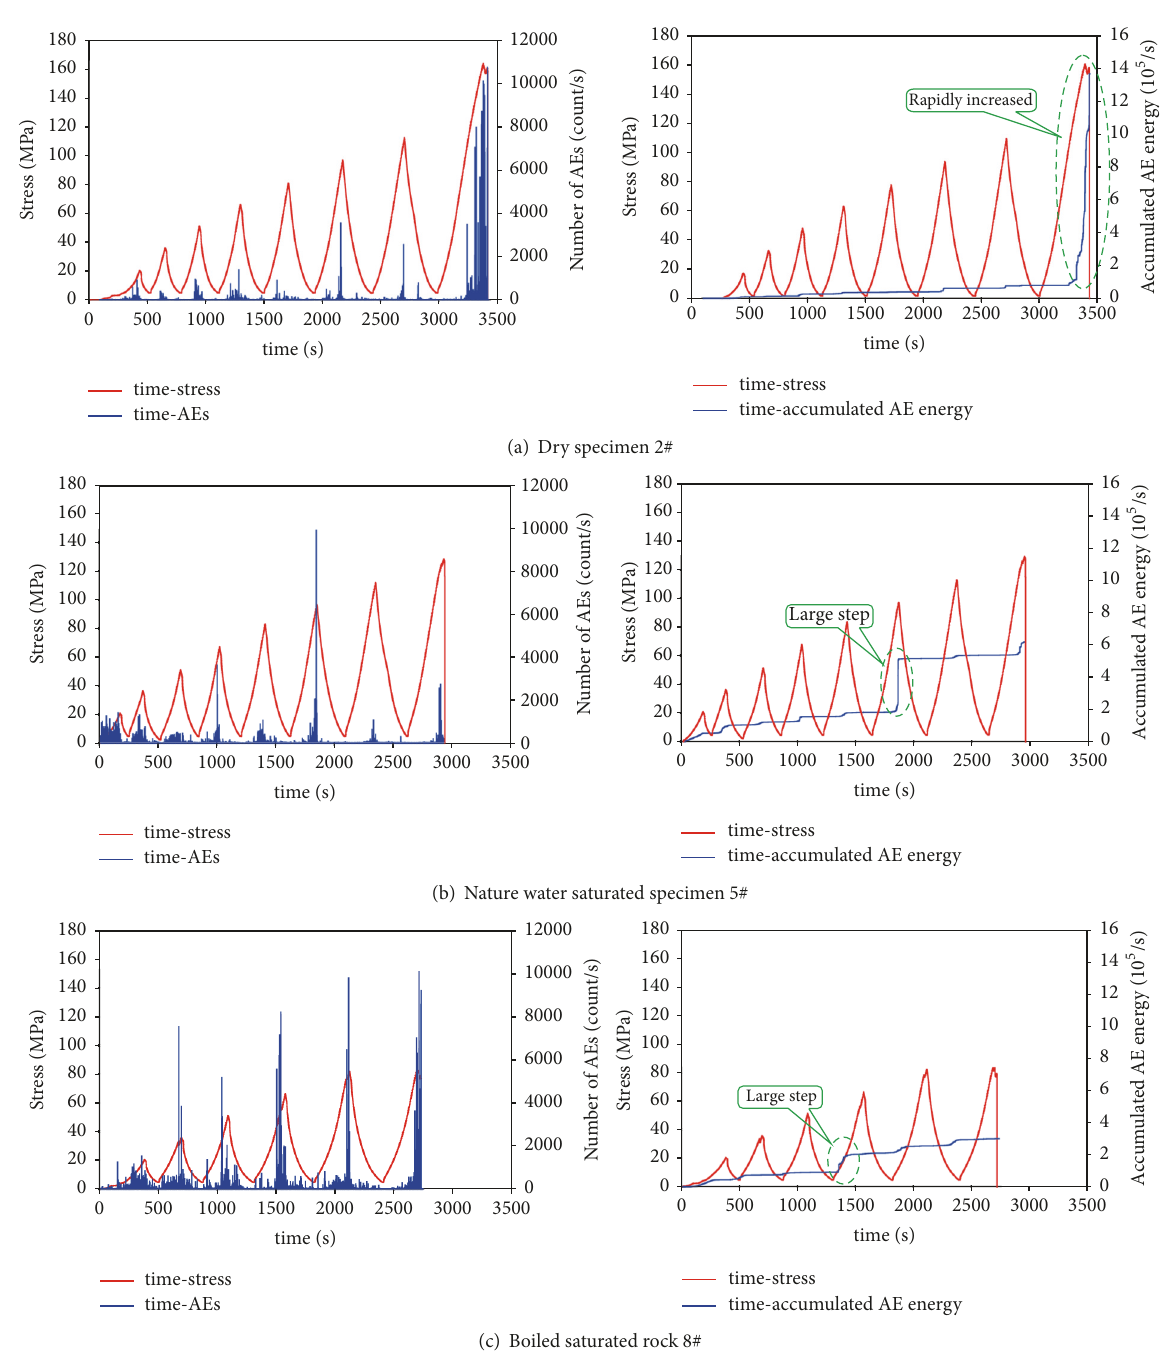
Figure 11: Comparison between the axial stress, cumulative AE energy, and AE counts with time of specimens with different water content Felicity